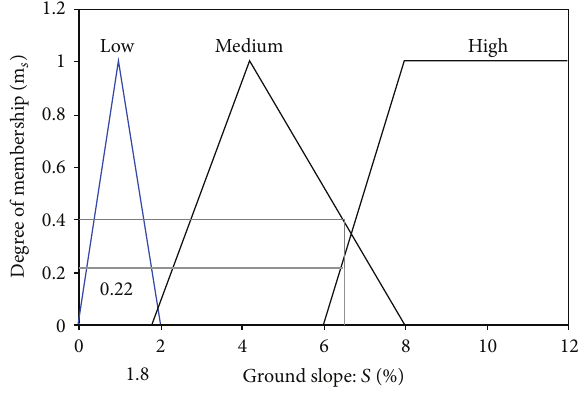
Figure 30: Membership functions for 𝑆